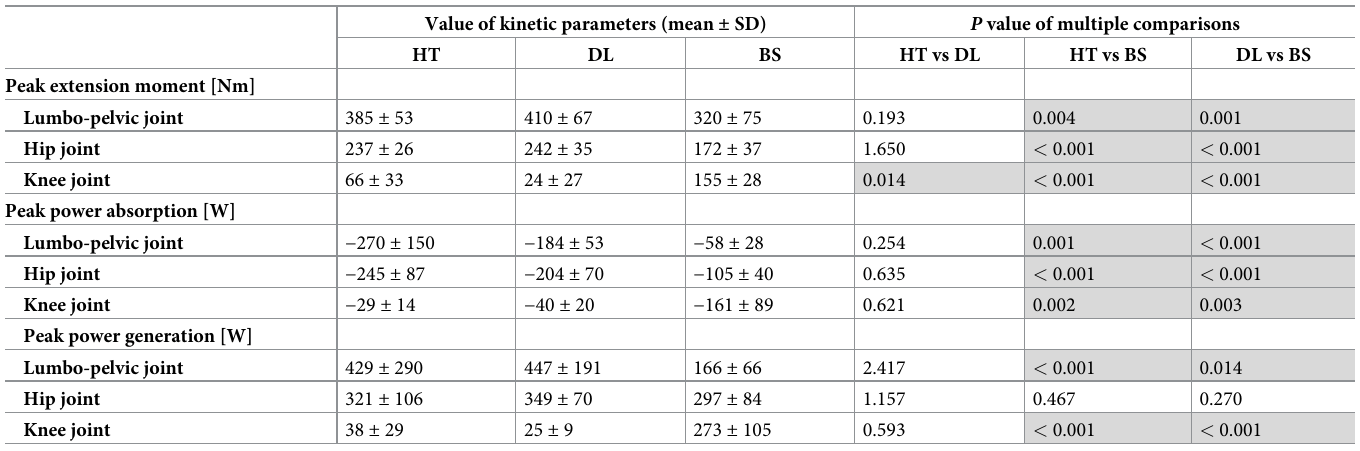
Significant difference between exercises are highlighted by grey